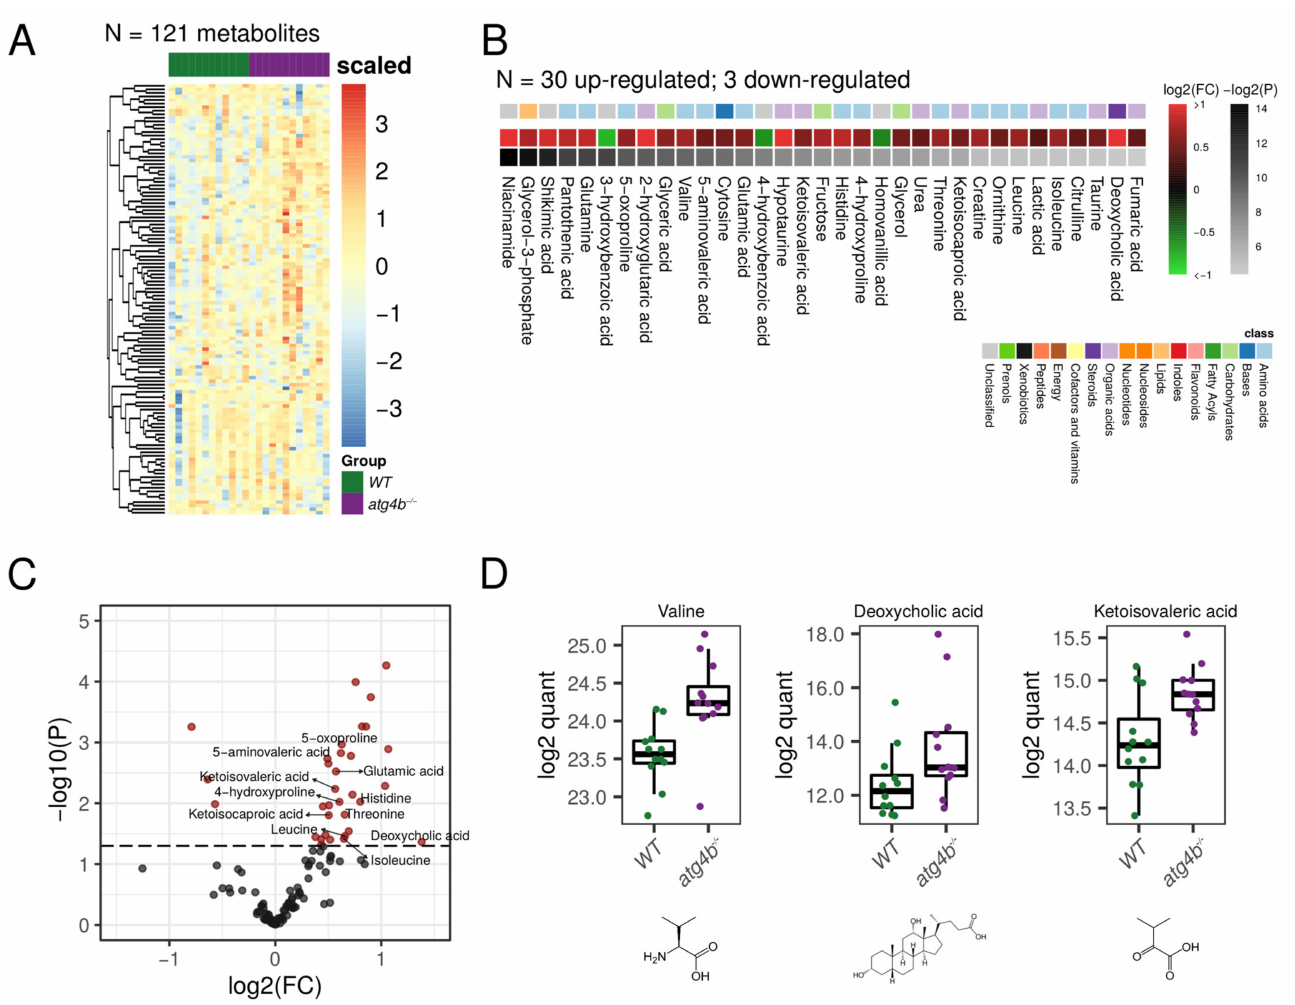
Figure 5. Autophagy deficiency upon ATG4B loss in plasma. ( A ) Heatmap showing the row-scaled log2 quantification levels of all the profiled metabolites in plasma samples. ( B ) Heatmap describing the change (log2 of fold change) of the metabolites with significantly altered levels between WT and atg4b − / − samples. ( C ) Volcano plot comparing the effect size (log2 of fold change) to the significance ( − log10 of p -value) of the metabolites altered between WT and atg4b − / − samples. Significant metabolites are colored in red. Representative metabolites are labeled within the plot. ( D ) Boxplots showing the log2 quantification levels of three representative metabolites, which are significantly altered between WT and atg4b − / − samples. Significance is defined as an unadjusted p -value <